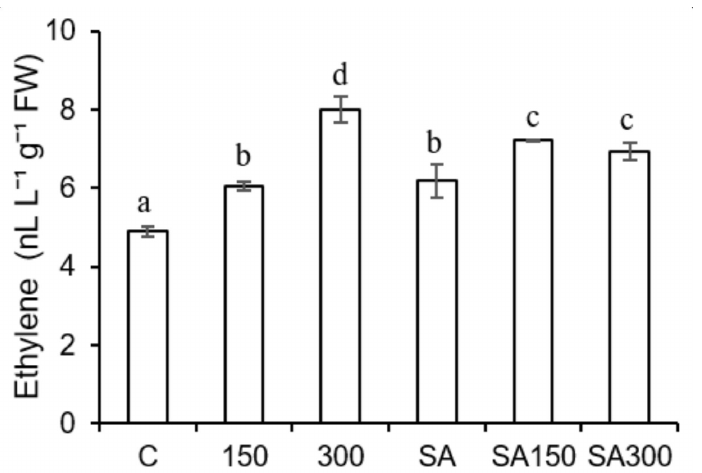
Figure 4. Effect of salicylic acid (SA) pre-treatment on ethylene levels of Hordeum vulgare L. ‘Ince- 04 (cid:48) plants under control and saline conditions (150 and 300 mM NaCl). Different letters indicate significant differences between treatments ( p <